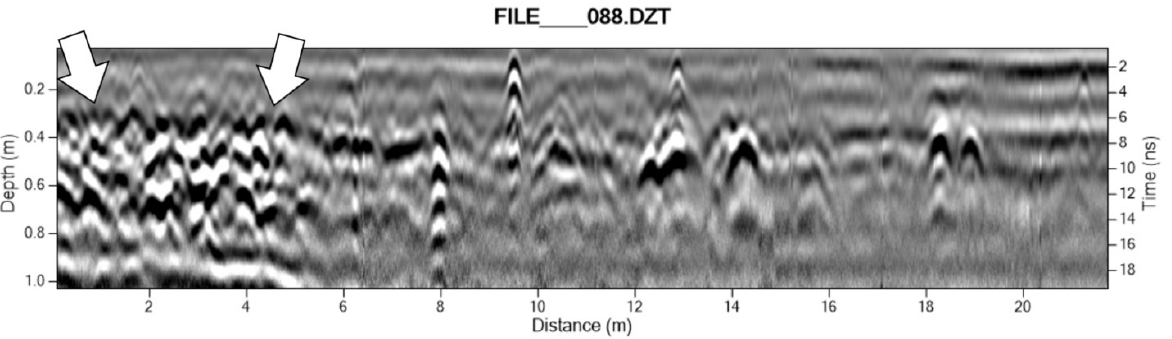
Figure 20. Wall-parallel transect at San Juan Bautista Building B; Rubble and possibly adobe bricks appear as a node cluster at left (0–4.5 m).